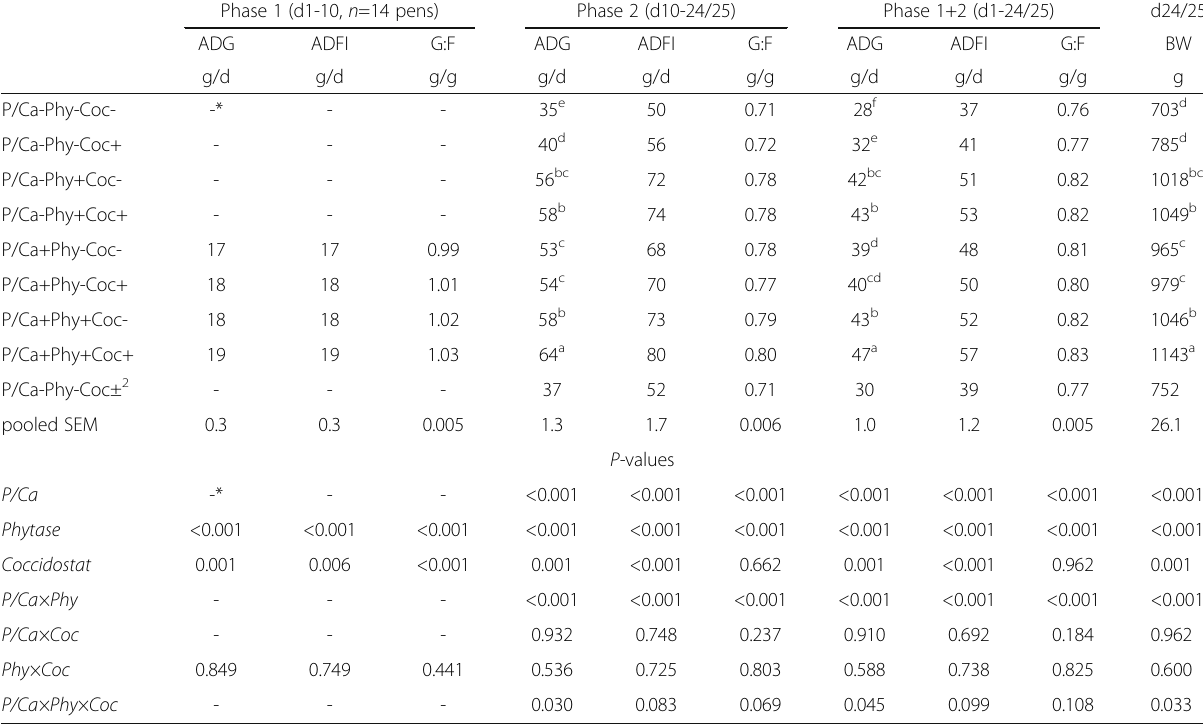
Table 1 Effect of the experimental diets on performance traits of broilers